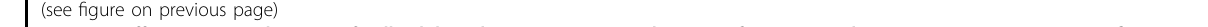
Fig. 3 A stiffness-triggered positive feedback loop between Piezo1 and integrin β 1 emerges during CF activation. a Immuno fl uorescence analysis indicated that, in CFs cultured on stiff matrices, but not in CFs cultured on “ medium ” or “ soft ” matrices, Piezo1 expression increased with increasing RGD concentration on the matrix (grey, Piezo1). Scale bar, 50 μ m. b Quanti fi cation of the immuno fl uorescence staining in panel a ( n ≥ 17 cells). c Blocking of integrin β 1 by antibodies eliminated these effects in CFs cultured on stiff matrices, reducing both expression of Piezo1 (grey, Piezo1) and cytosolic Ca 2 + concentrations (Fluo-4 AM). Scale bar, 50 μ m. d Knockdown of Piezo1 with siPiezo1 reduced expression of integrin β 1 (green) and the focal adhesion proteins vinculin and paxillin (red). Scale bar, 10 μ m. e , f Quanti fi cation of the fl uorescence intensities in panel c ( e n ≥ 11 cells; f n ≥ 50 cells). g , h Quanti fi cations of the data in panel d ( n ≥ 17 data points). i Overexpression of Piezo1 with Yoda1 increased expression of integrin β 1 on stiff hydrogels but not soft matrix. Scale bar, 10 μ m. j Quanti fi cations of the data in panel i ( n ≥ 75 data points). k Schematic diagram of the